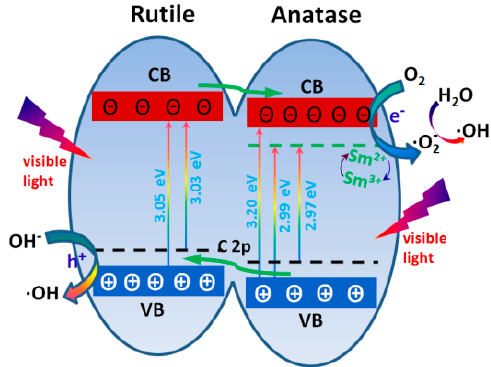
Figure 8. Schematic illustration for the twin synergistic effects of Sm-C co-doping and the mixed phase TiO 2 . In our experiment, the band gap of rutile TiO 2 may show the band gap of TiO 2 as the 3.05 eV, the band gap of C-TiO 2 , Sm-TiO 2 , and Sm-C-TiO 2 are 3.03 eV, 2.99 eV, and 2.97 eV, respectively, indicating that the C and Sm form impurity energy levels.